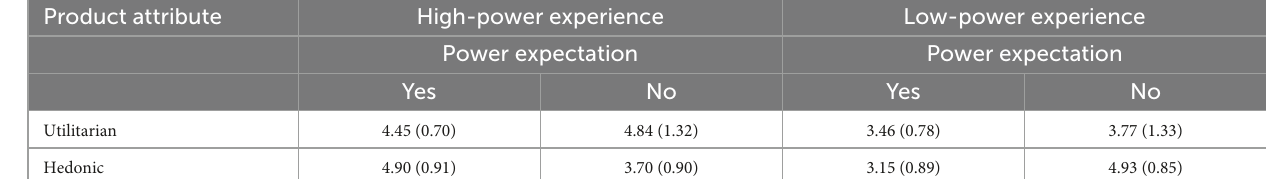
TABLE 3 Results of comparisons of deservingness in different